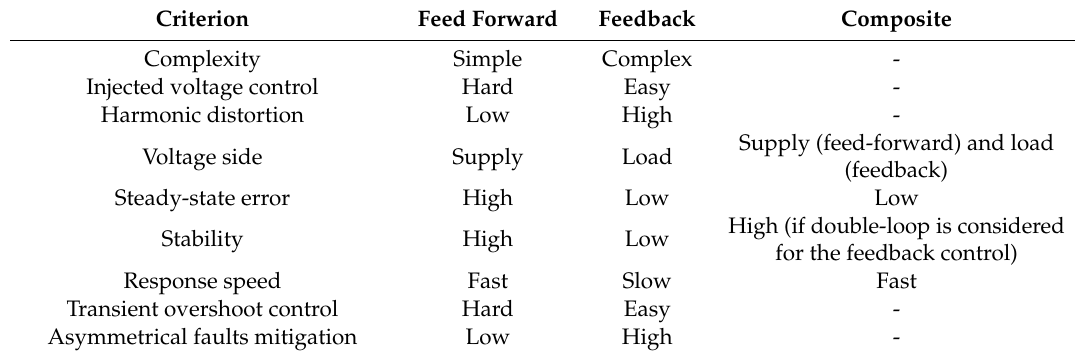
Table 9. Comparison between Feedback, Feed-forward, and Composite controllers. Based on data from